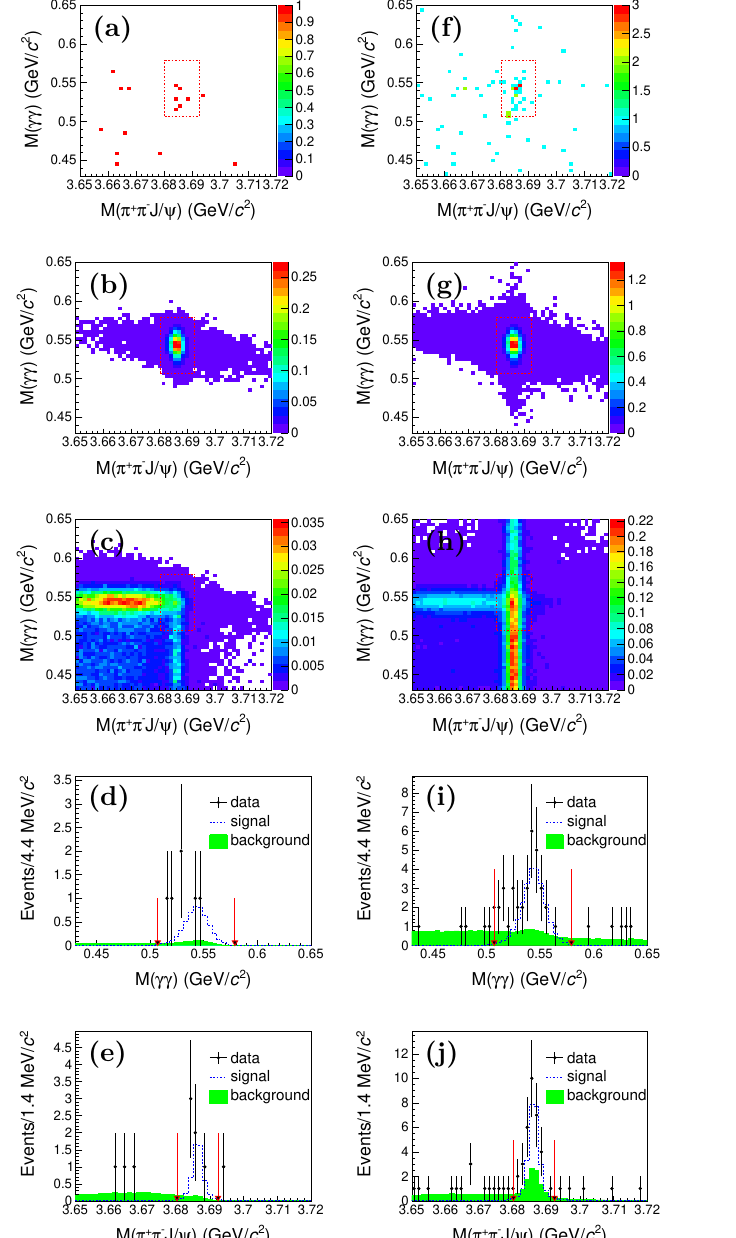
Figure 1. Two-dimensional distributions of M ( γγ ) versus M( π + π − J/ψ ) for (a) data, (b) signal MC simulation, and (c) background MC contributions with the red dashed boxes for the defined η and ψ (2 S ) signal regions, and the corresponding projections of (d) M ( γγ ) distribution in the ψ (2 S ) mass window and (e) M ( π + π − J/ψ ) distribution in the η mass window with red arrows for √ the defined signal regions at s = 4 . 258 GeV, where the dots with error bars, the dashed blue lines, and the green histograms represent data, signal MC, and background MC simulations, respectively. The same distributions for the sum of the 14 data samples and MC samples are shown in (f), (g), (h), (i), and (j) correspondingly.